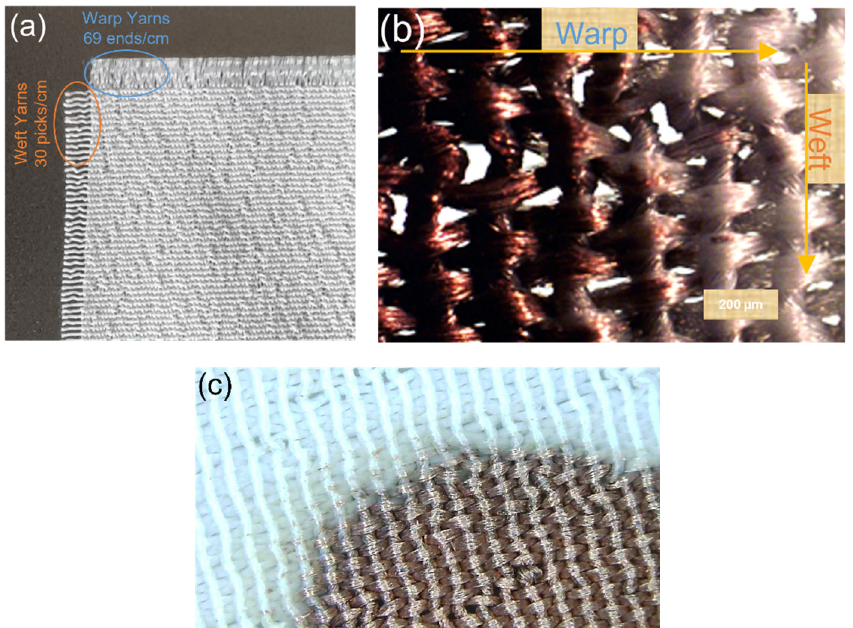
Figure 8. ( a ) Image of the untreated polyester textile under magnifying counting glass; ( b ) optical microscopy image of the metallised textile; and ( c ) optical microscopy image of the border between the metallised section and the non-metallised section.